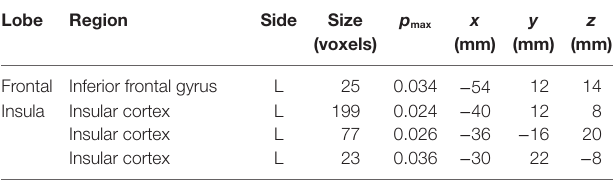
L, left. The cluster sizes are indicated in voxels in standard space (voxel size: 2 mm 3 isotropic). The maximal p-value is reported in the fifth column. Peak p-value coordinates are reported in the MNI152 standard space. There were three partly separable volumetric clusters detected in the area of the left insular cortex.